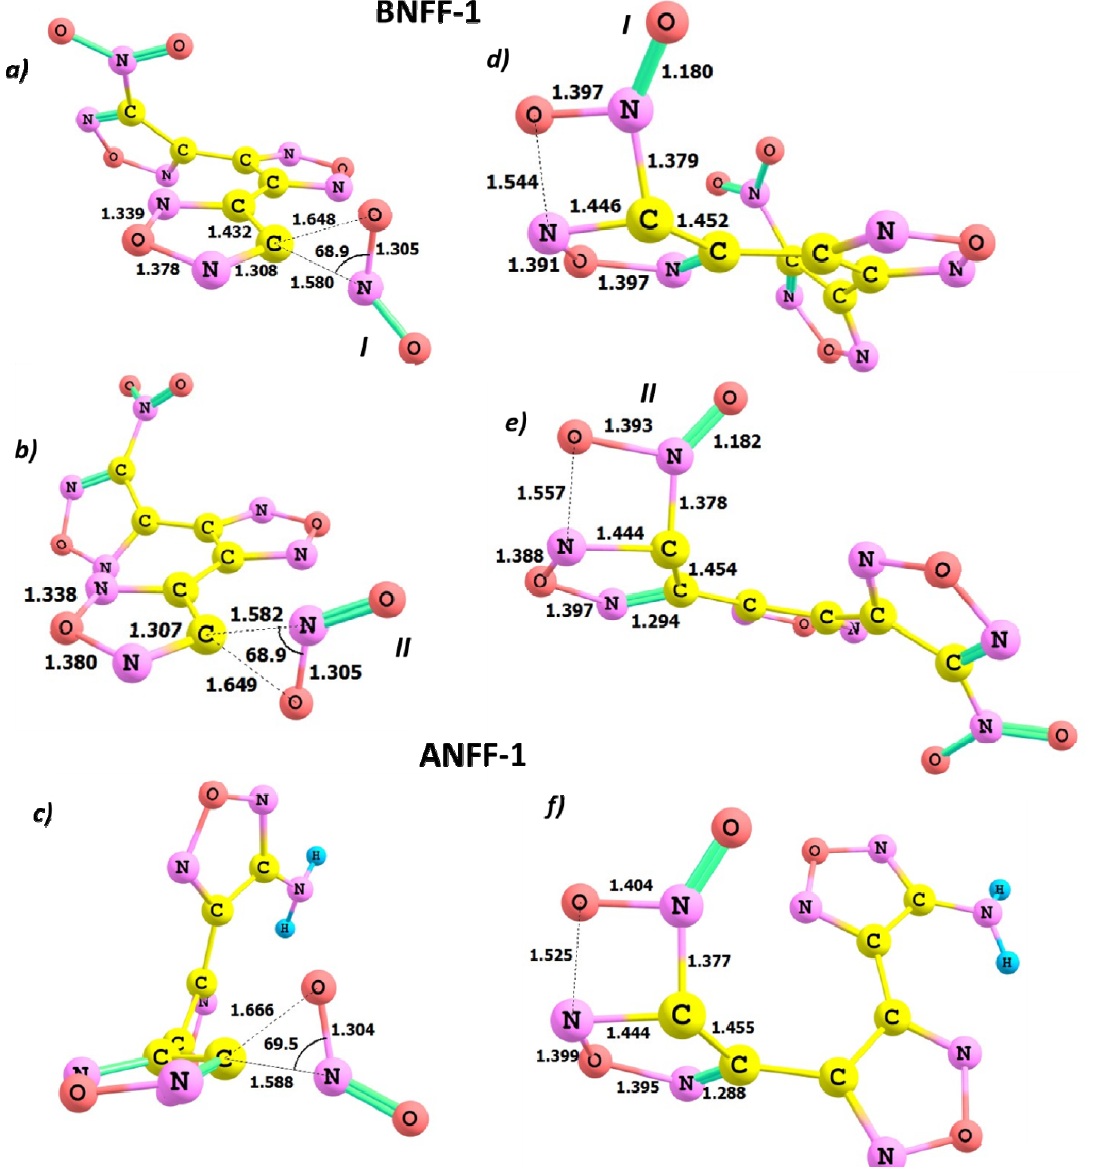
Figure 5. The structures of transition states of ( a – c ) the CONO rearrangement and ( d – f ) the O-transfer reaction pathways in BNFF-1 and ANFF-1. The bond distances (Å) are obtained with M06